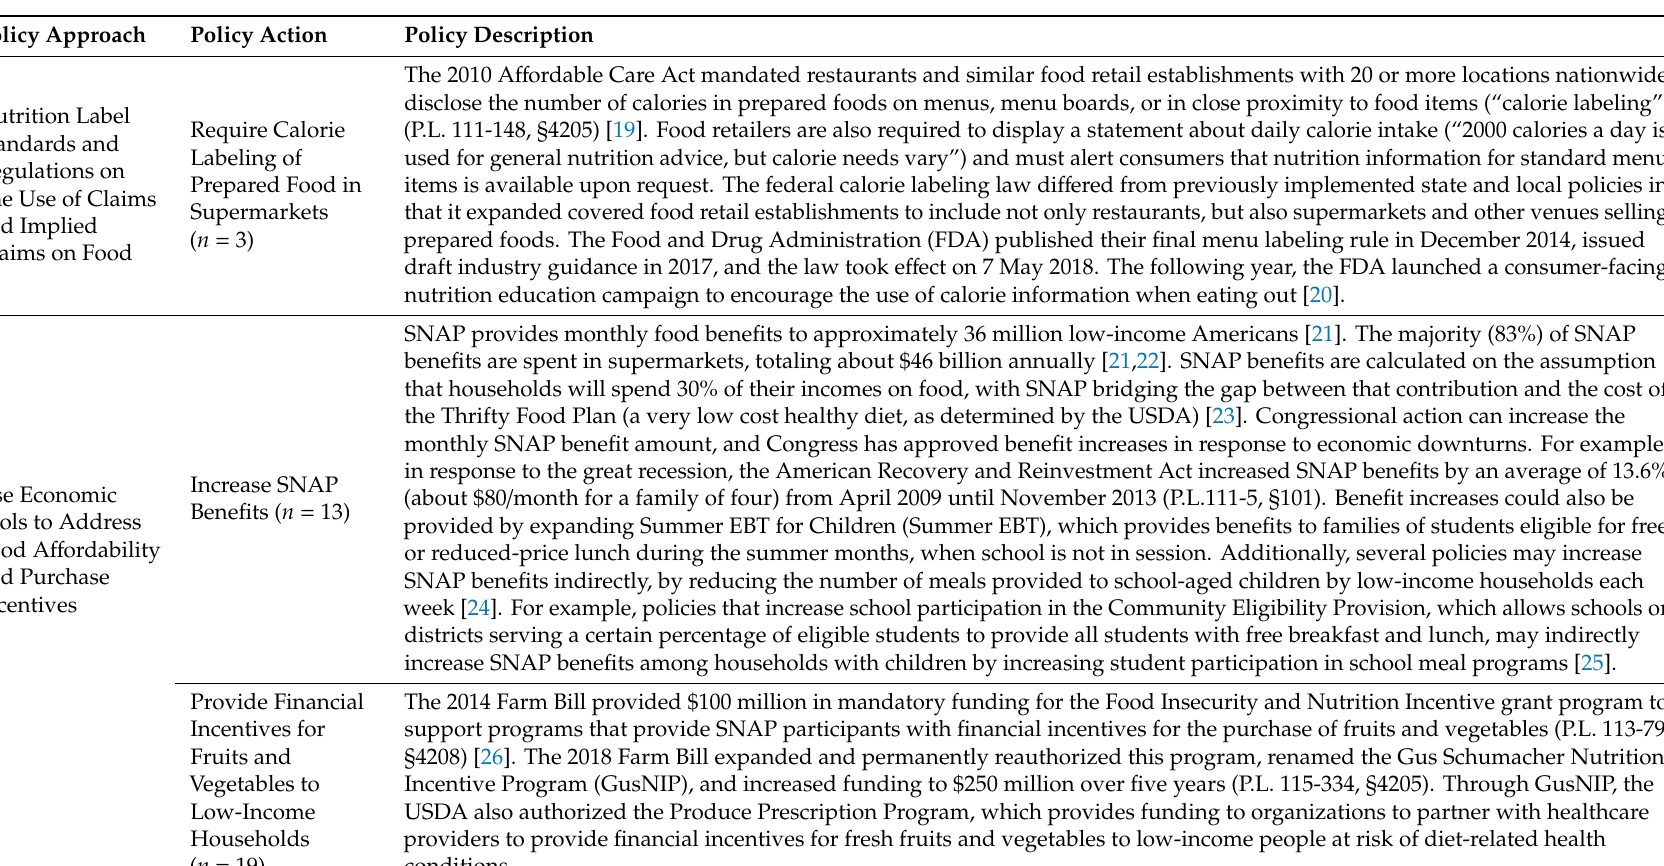
Table 1. Description of policy actions included in the